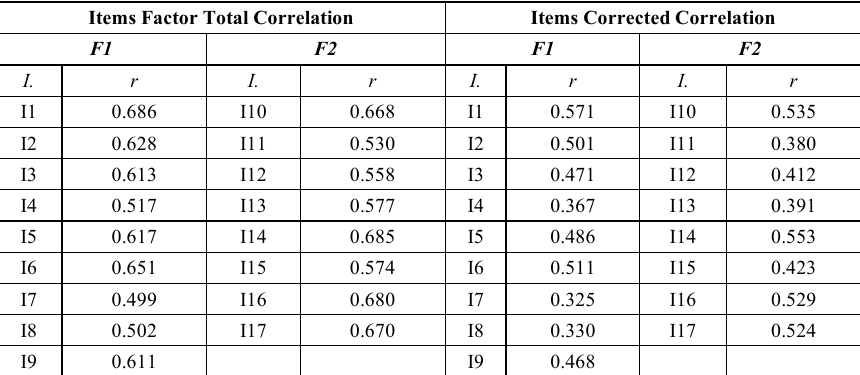
Table 3. Item – Factor Correlation Analysis